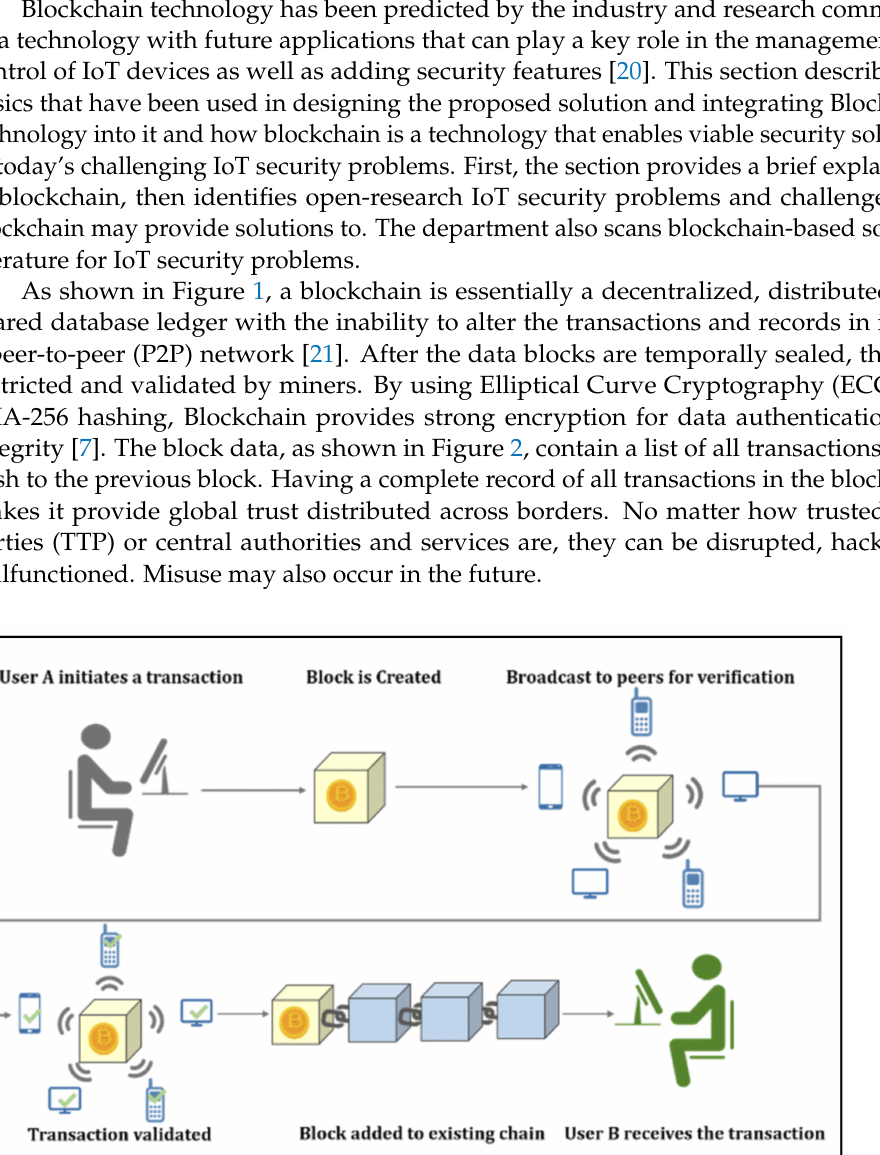
Figure 1. Blockchain